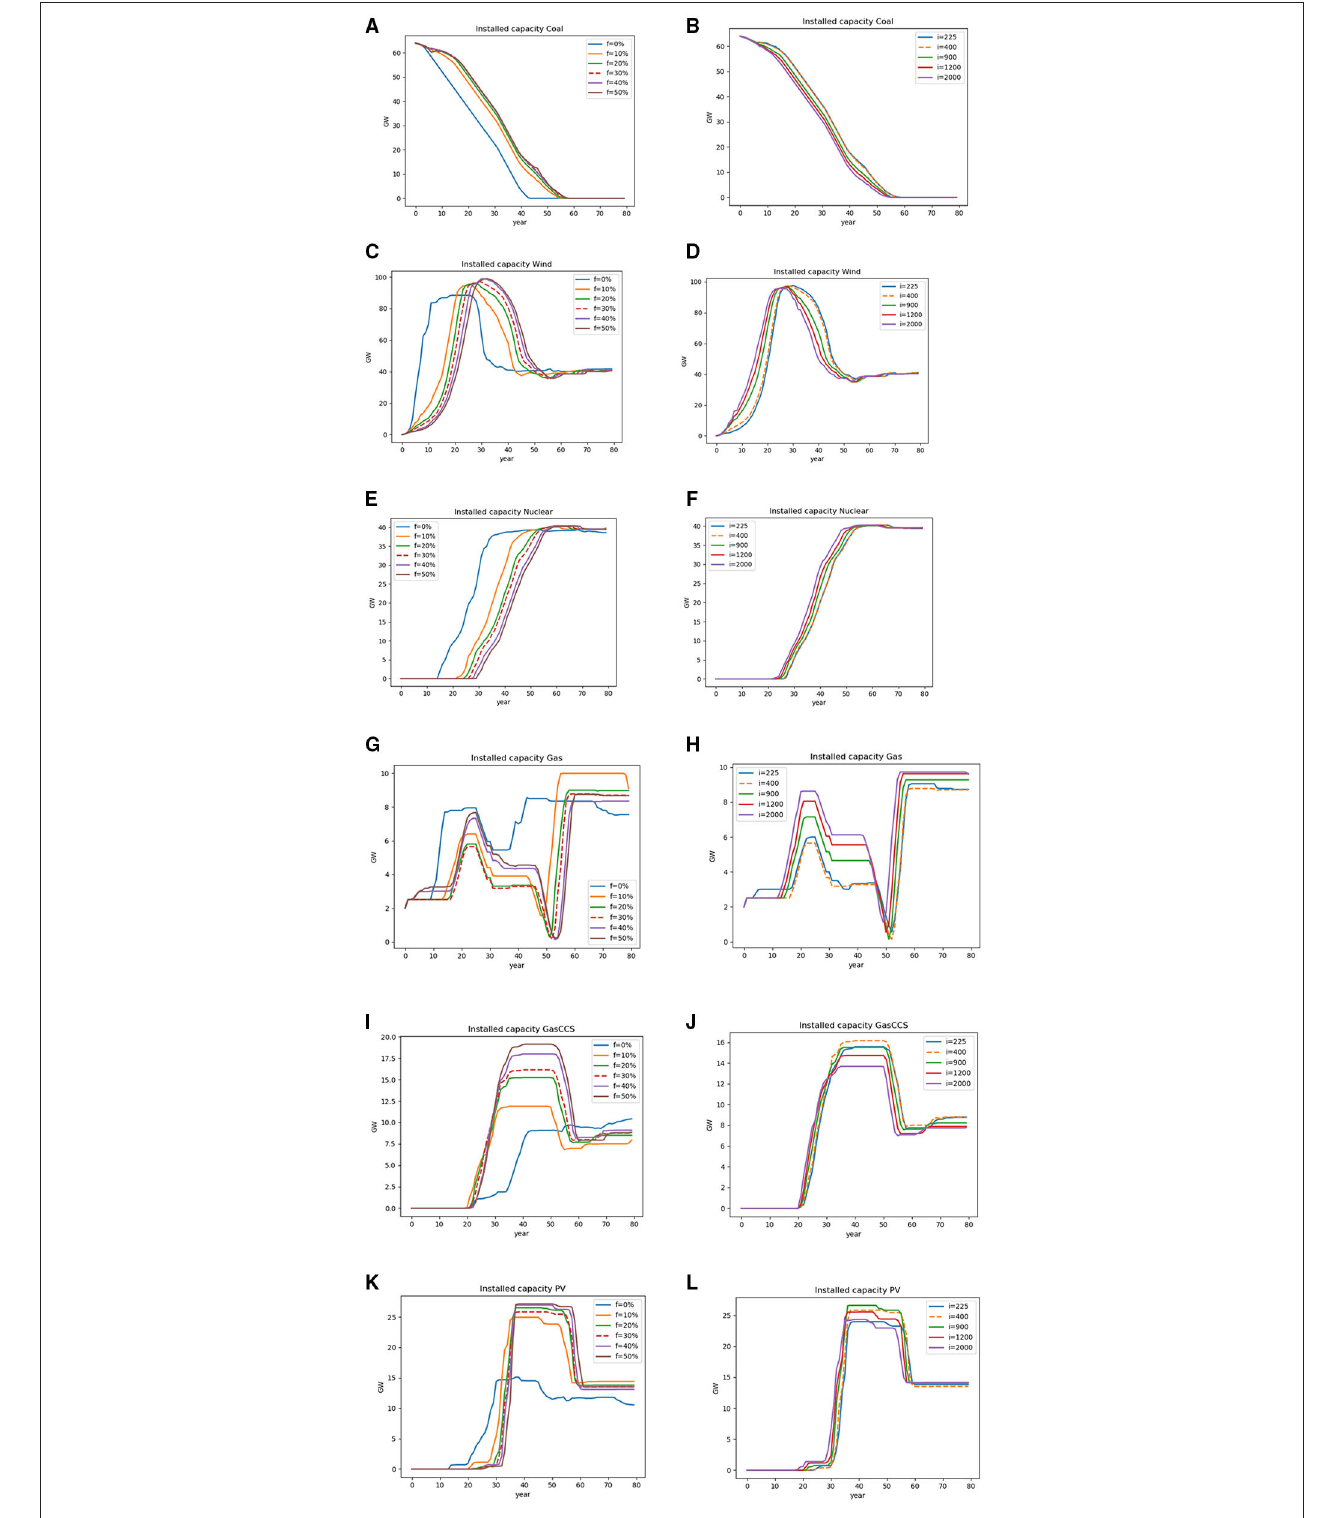
FIGURE 8 | Installed capacity in cases with different capital accessibilities. (A,B) Coal; (C,D) wind; (E,F) nuclear; (G,H) gas; (I,J) gasCCS; (K,L) solar PV. “f” is the fraction of an investment financed by a company’s own capital and “i” is the initial capital in a company’s bank account. Dashed line is the base case.